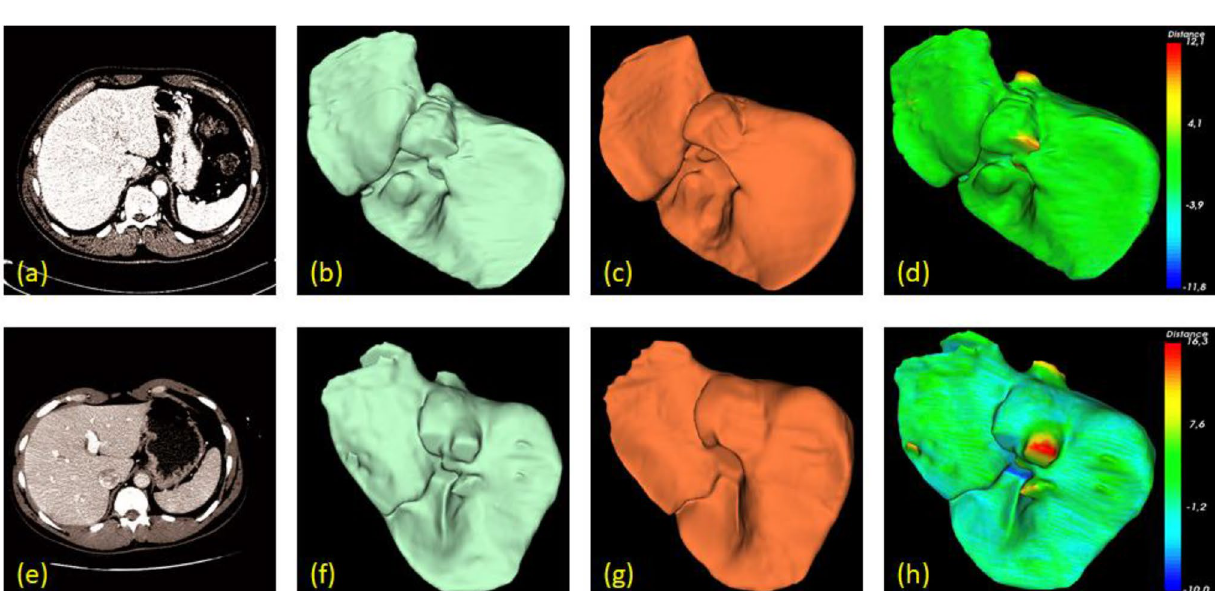
Figure 9. Selected examples of two healthy livers (top and bottom rows) in SLIVER07 dataset. The first column ( a , e ) shows an original image. The second ( b , f ) and third ( c , g ) columns show the segmented results and respective ground truths. The last column ( d , e ) shows the error distance (in mm) between our results and reference livers. The green color on the surface corresponds to the low error rate, while red and blue colors correspond to the high positive and negative ones,